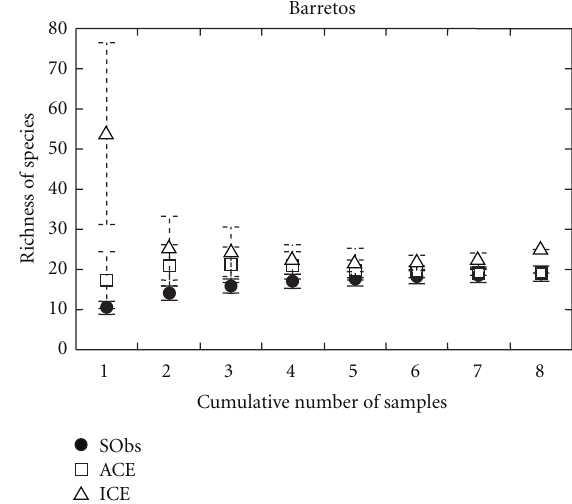
Figure 3: Richness of species observed and estimated using ACE (Abundance-based Coverage Estimator) and ICE (Incidence-based Coverage Estimator) indexes to the area of Bebedouro.